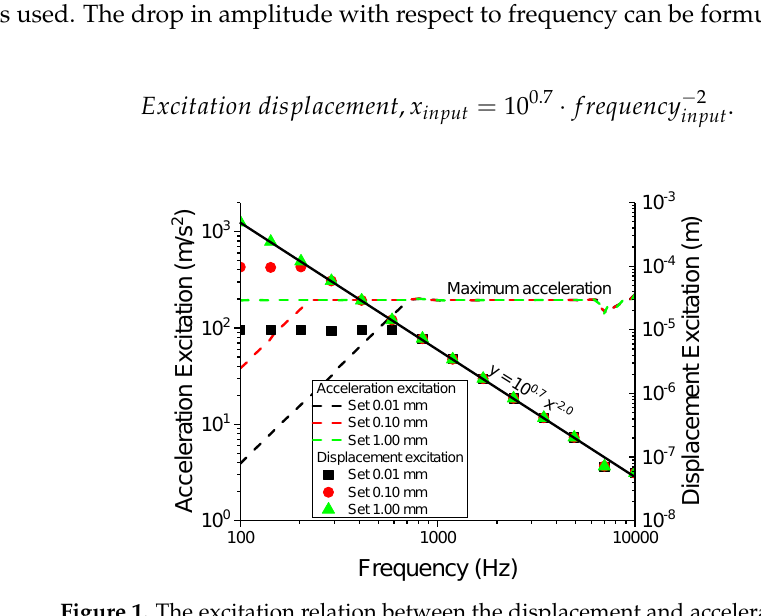
Figure 1. The excitation relation between the displacement and acceleration.